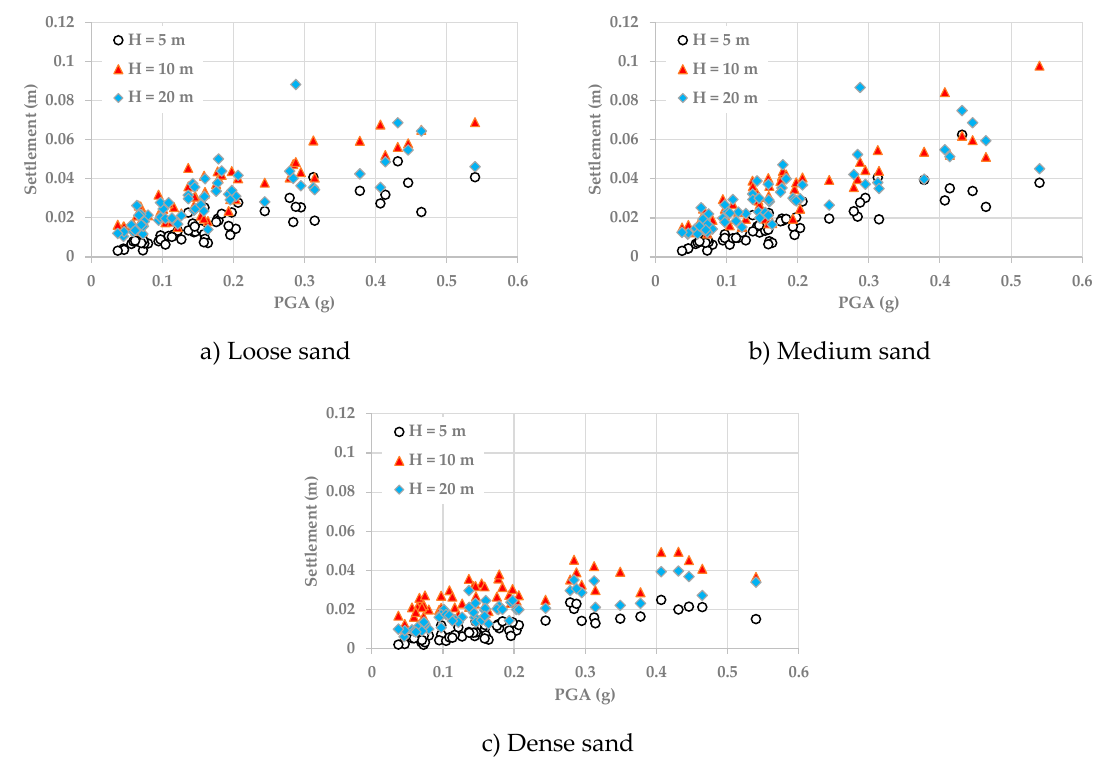
Figure 7. Effect of the thickness of the liquefiable layer on the liquefaction-induced seismic settlement.